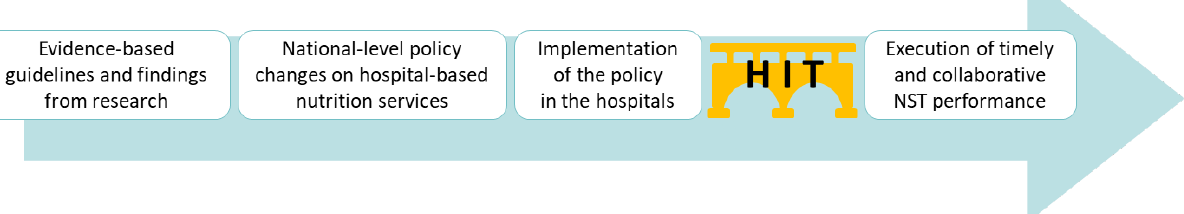
Figure 6. For timely and collaborative performance by the nutrition support team (NST), the role of healthcare information technology (HIT) is depicted in bridging the gap between policy implementation and the provision of clinical services at a hospital in South Korea.